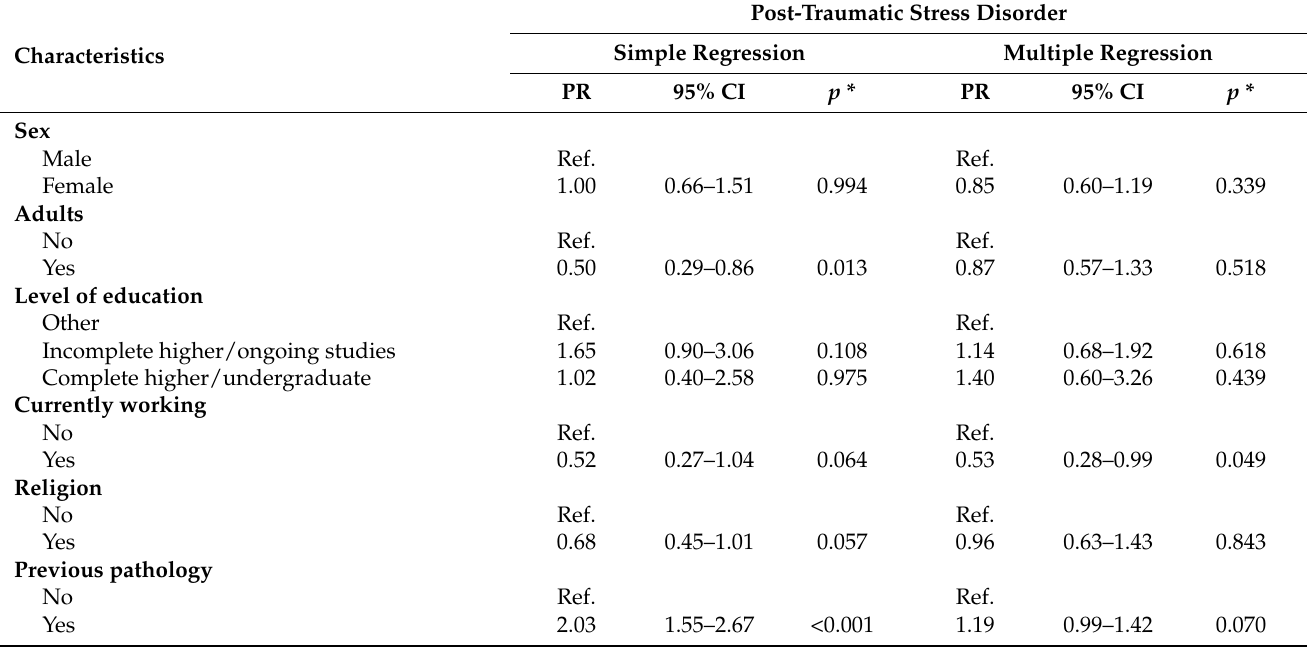
Table 3. Resilience and other factors associated with PTSD in the simple and multiple regression